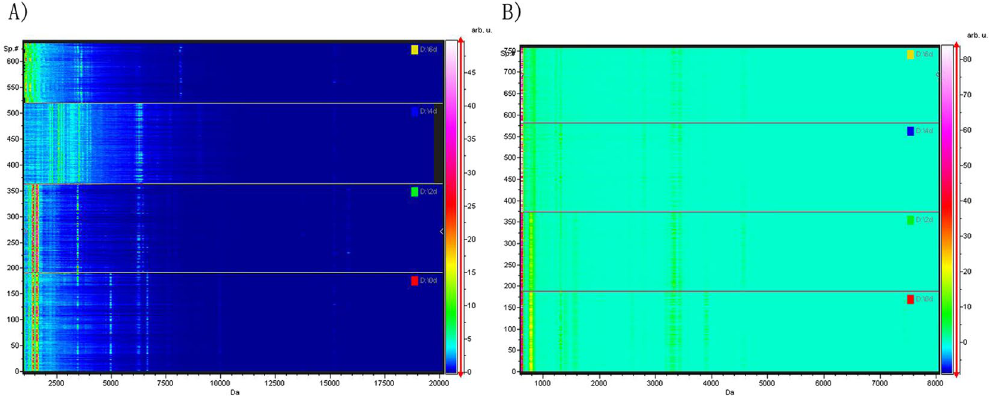
Figure 5. Gel view of data from different PMI groups. ( A ) In SD rat liver samples; ( B ) in human liver samples.